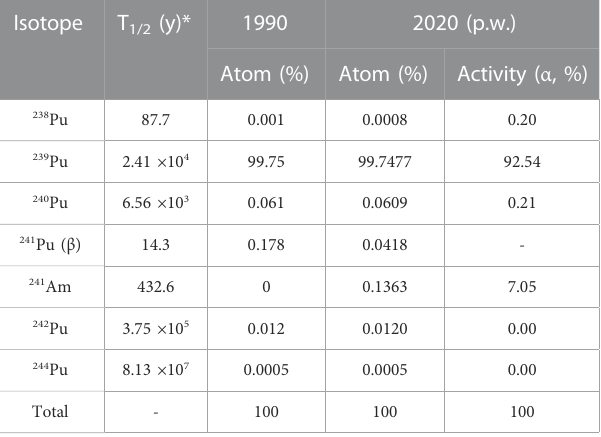
TABLE 1 Isotopic inventory of PuO 2 (s) (ORNL, USA) and its activities.